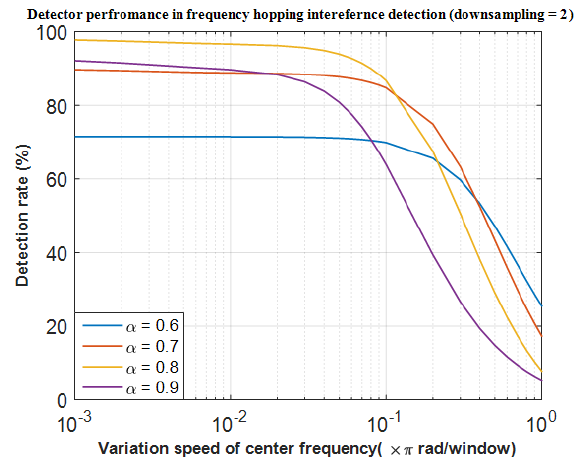
Figure 15. Detector performance in hopping Continues Wave Interference (CWI) detection.